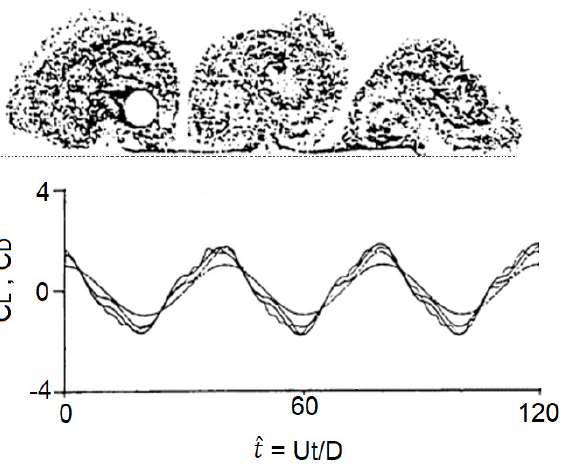
Figure 17. The flow pattern at t = 120, and the force coefficients for G/D = 1, Kc = 40 and Re = 25,000. As the gap ratio is reduced to G/D = 0.5, the difference in the amplitude of the